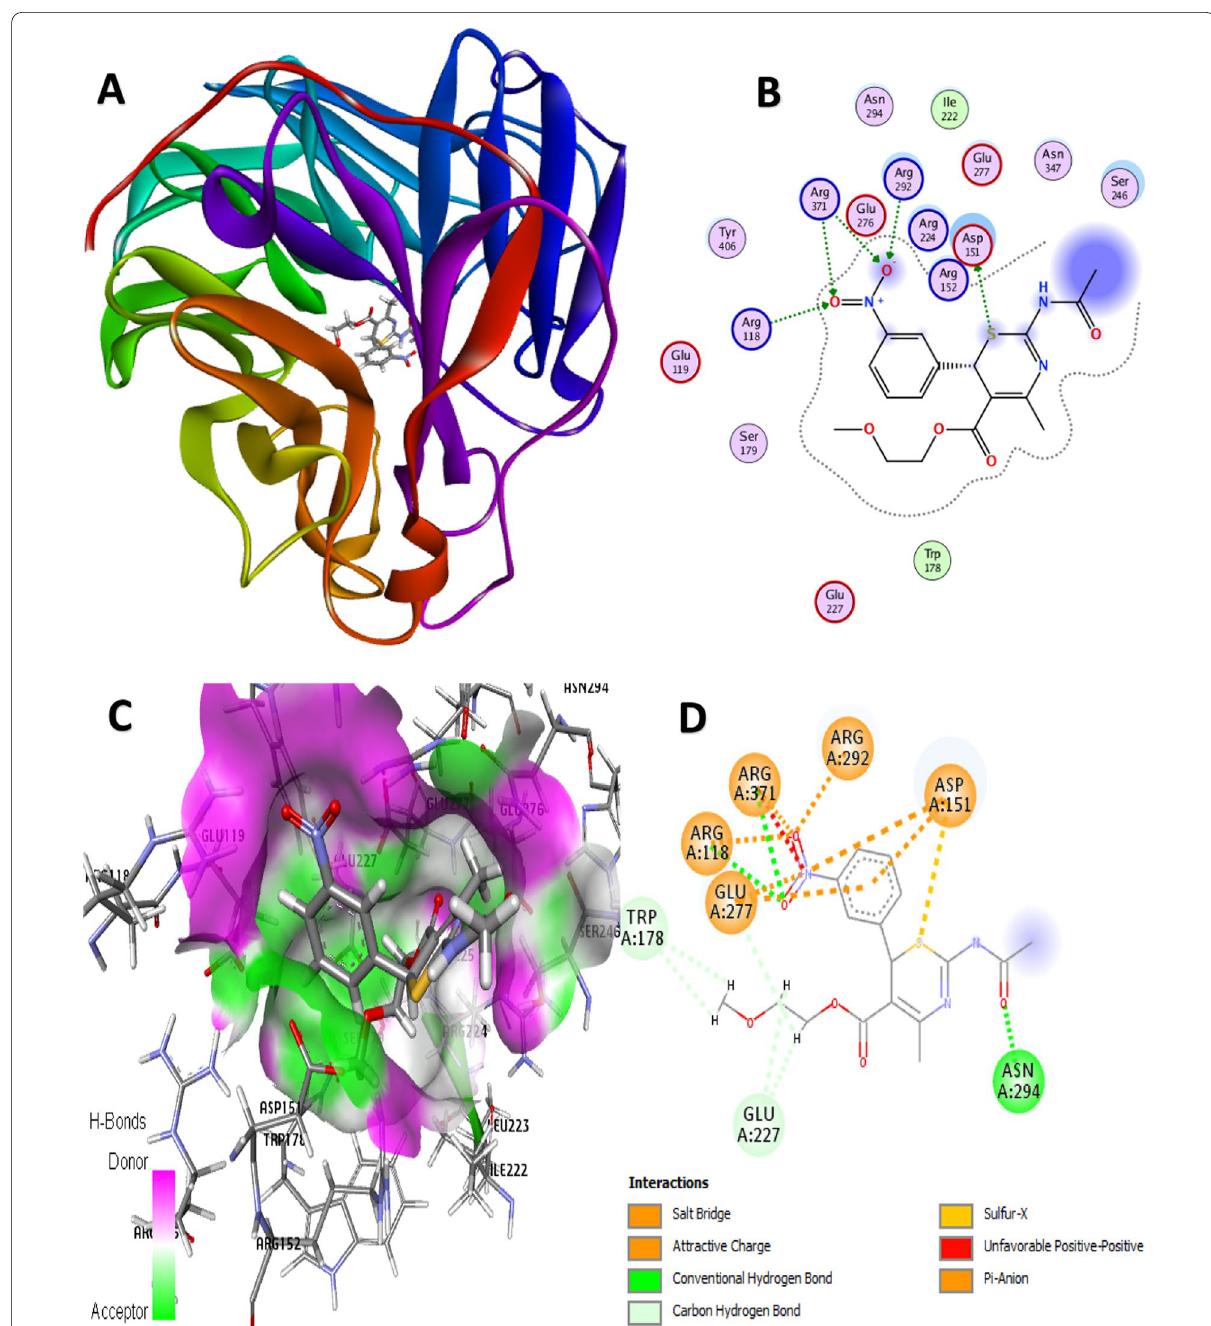
Fig. 11 3D docking view of compound 15 with the H1N1 neuraminidase receptor (PDB: 3TI6). A The best pose of compound 15, B residual interaction of compound 15-complex, C 3D hydrogen bond surfaces around the ligand, D 2D residual interaction of compound